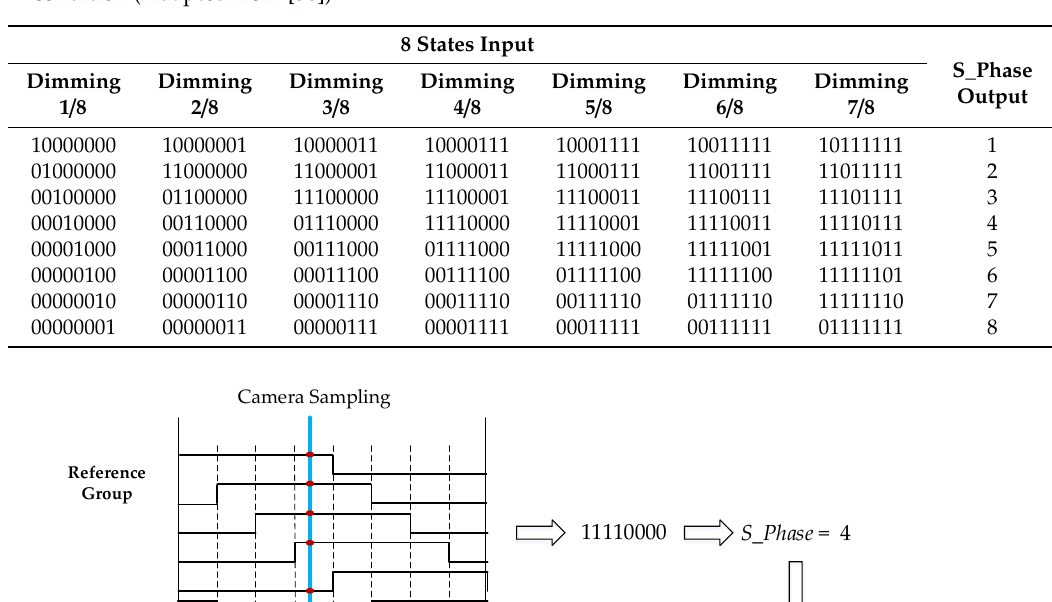
Table 2. S_Phase value definition for the captured set of binary LED group states under dimming condition (Adapted from [30]).